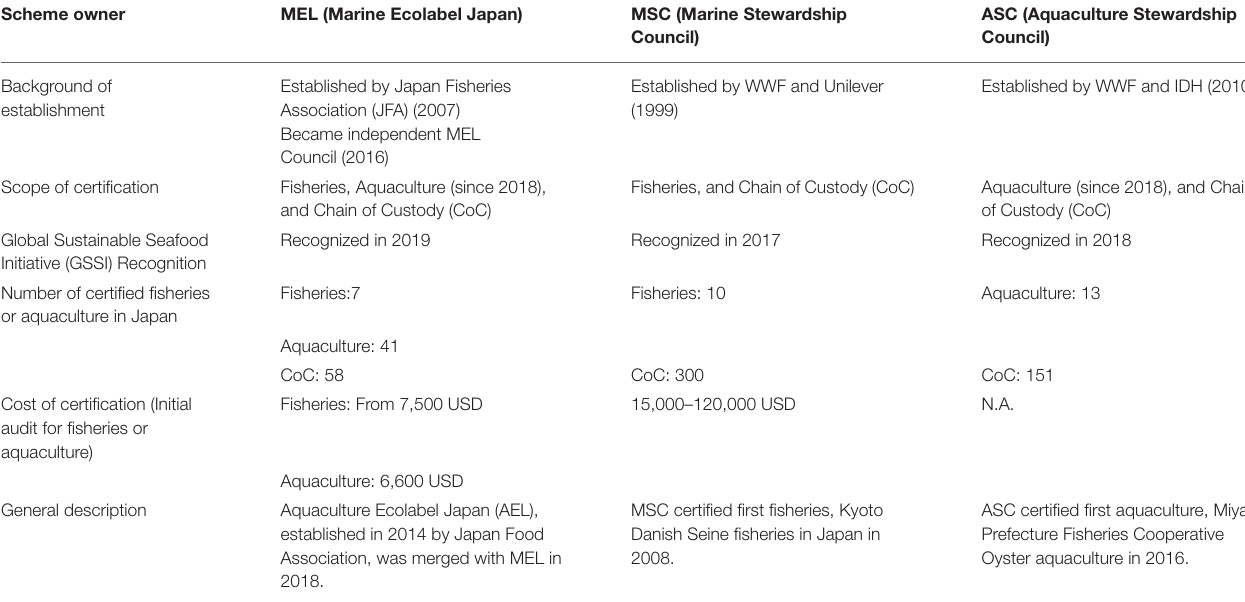
TABLE 1 | List of certification schemes present in Japan. Scheme owner